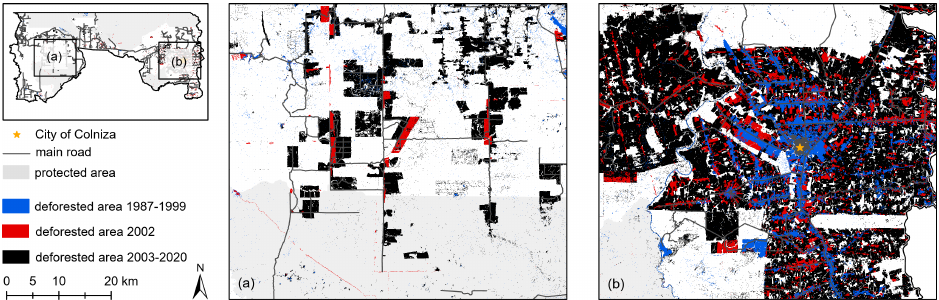
Figure 12. Deforestation patterns in Colniza: ( a ) newly developed roads and rectangular cleared patterns in the West as of 2002; ( b ) predominant fishbone patterns in the East (data basis: